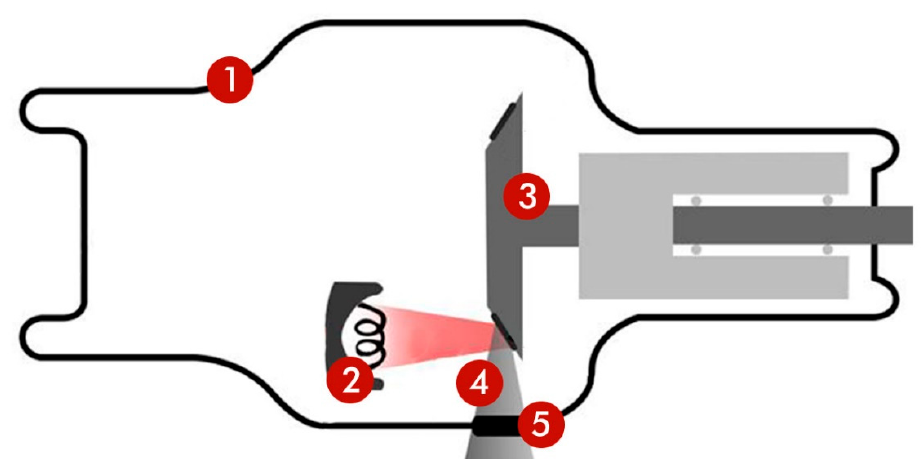
Figure 2. The X-ray tube: (1) shield, (2) electron filament, (3) target, (4) X-ray radiation beam, and (5) window.